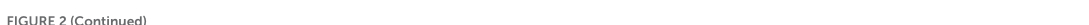
the three subgroups across age. Of the values of large-airway function, the CV was significantly higher in the 45- to 60-year subgroup (4.666 ± 1.946, P = 0.002 for FEV 1 ; 4.565 ± 2.478, P = 0.017 for FEV 3 , Table 3) than in the 30- to 45-year subgroup (2.906 ± 0.8121 for FEV 1 ; 2.739 ± 0.8813 for FEV 3 ) and the 18- to 30-year subgroup (2.489 ± 0.8739 for FEV 1 ; 2.648 ± 0.8069